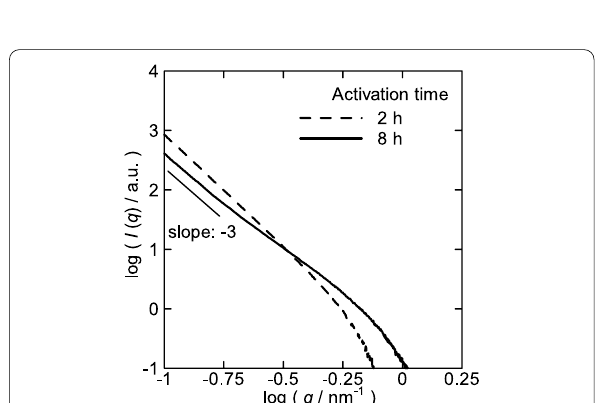
Fig. 4 Small angle X-ray scattering (SAXS) profiles of activated tunicate cellulose (TC) carbons prepared using various impregnation times. I ( q ) and q indicate scattering intensity and the absolute value of scattering